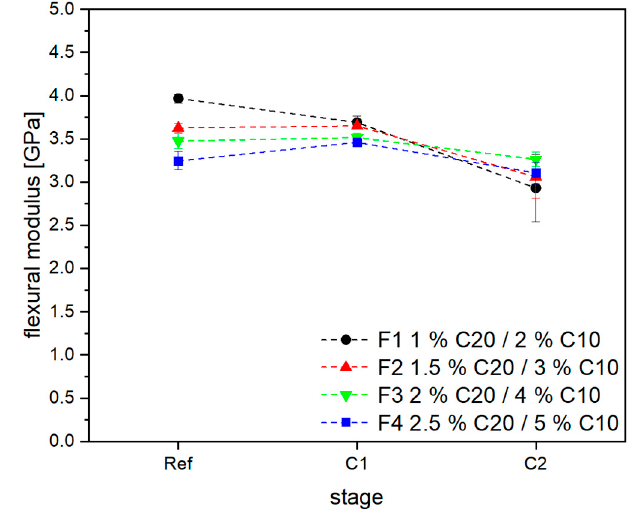
Figure 18. Flexural modulus of the four formulations in different stages.